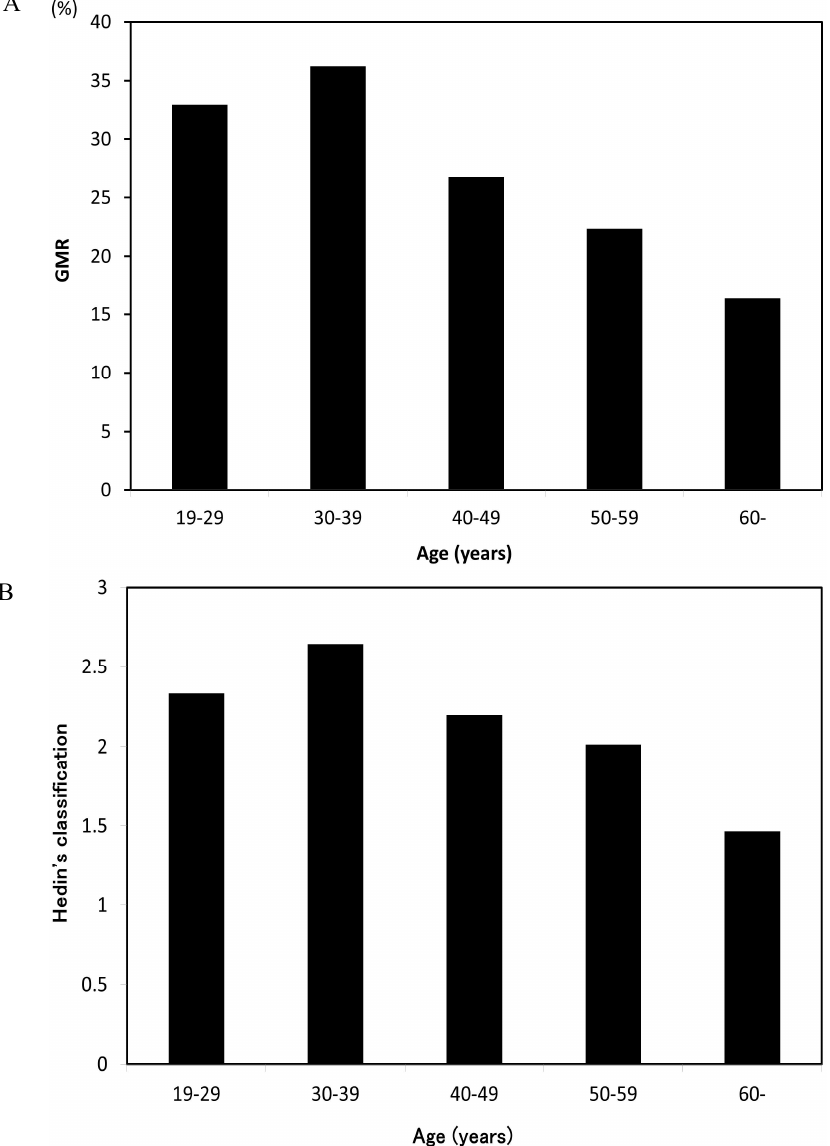
Figure 3. Mean GMR score ( A ) and Mean Hedin’s classification ( B ) grouped according to age at baseline.